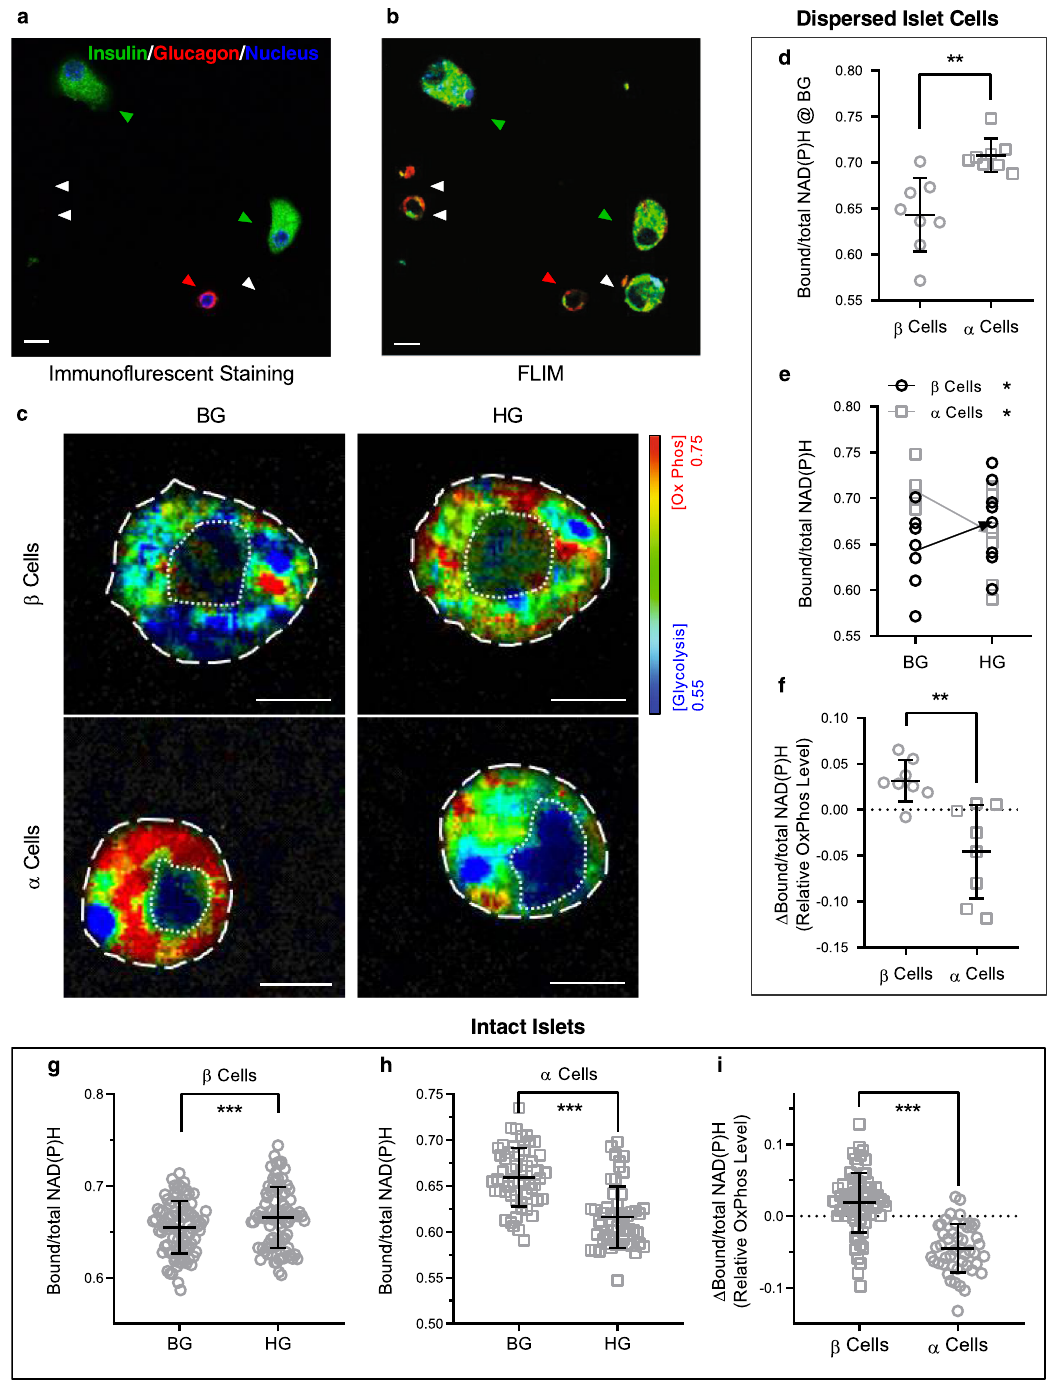
Fig. 2 Metabolic trajectory of β and α cells in response to glucose. a, b Mouse islets were dispersed into single cells, attached to a cover slip with imprinted grid, evaluated by FLIM and then fi xed and immunostained for glucagon and insulin ( a ) so that the FLIM studies could be attributed to α cells and β cells, respectively. Green arrows, β cells; red arrows, α cells; white arrows, unknown because cells detached during staining. Scale bar, 10 µ m. c Metabolic trajectory of dispersed Single primary β and α cells ( n = 8 cells each) imaged at basal glucose (BG, 4 mM) and after exposure to high glucose (HG, 16 mM) for 30 min. The pseudocolored images suggest that the β cells become more OxPhos after glucose treatment and the α cells become more glycolytic. Scale bar 5 µ m; dashed white line indicates cell outline and dotted line indicates the nucleus outline. d The basal glucose Bound/total NAD(P)H values for α and β cells are signi fi cantly different. e, f The opposite metabolic trajectories of dispersed α cells and β cells are revealed by plotting the Bound/total NAD(P)H values for each cell in BG and HG conditions, and calculating the Δ Bound/total NAD(P)H of β and α cells. n = 8 for each cell type. g, h, i In 8 intact WT mouse islets, we examined the Bound/total NAD(P)H and Δ Bound/total NAD(P)H value of 47 α and 72 β individual cells at basal and high glucose. Data are presented as mean ± SD. * P < 0.05, ** P < 0.01, the two-tailed paired t test was used for comparison of responses to BG versus HG in dispersed mouse islet cells. The two-tailed Mann – Whitney test was used in comparison of responses between α versus β cells from dispersed mouse islet cells. Linear mixed effect models were used to compare responses between islets cells in whole